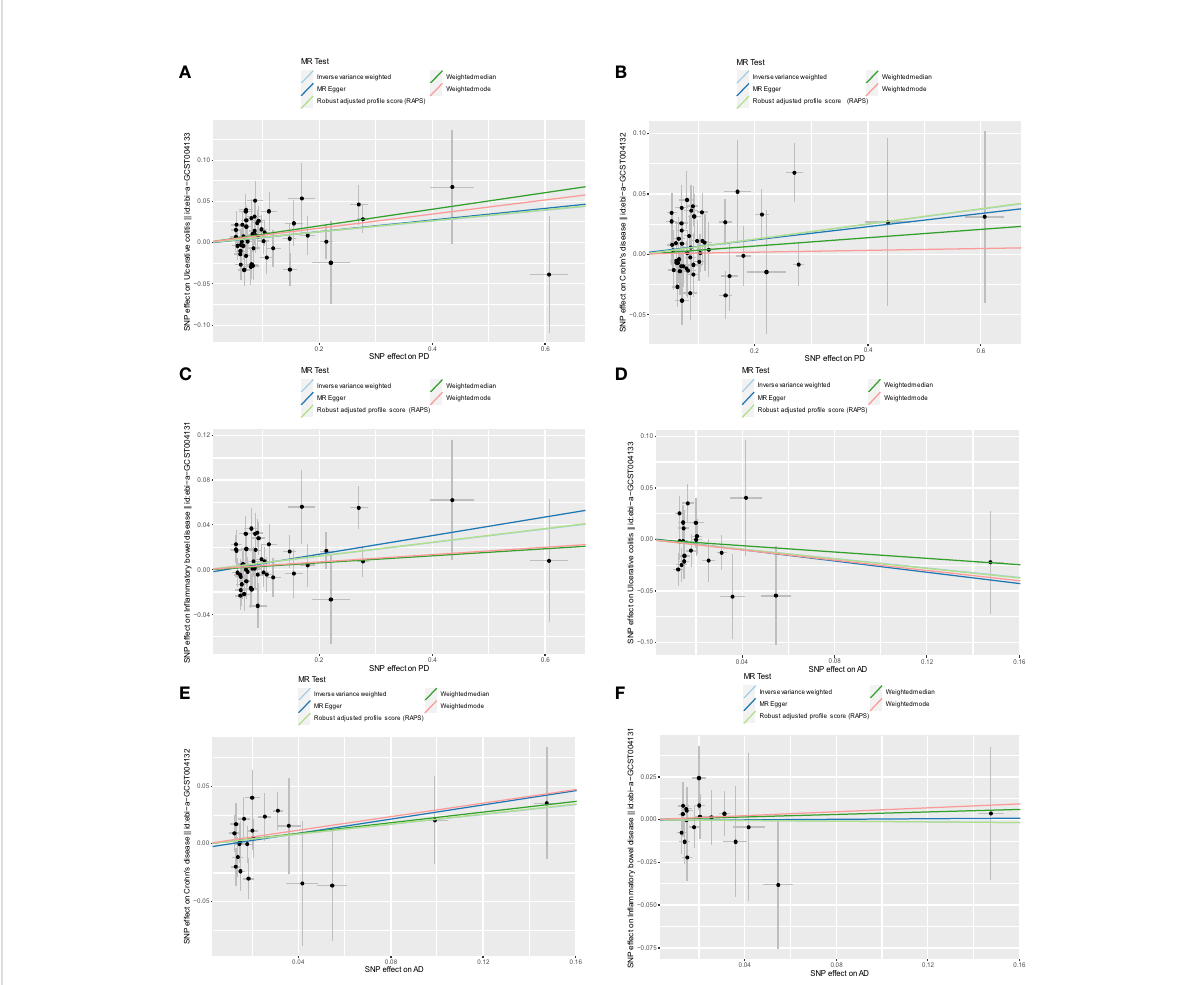
FIGURE 2 Scatter plots for MR analyses of the causal effect of PD and AD on IBD. (A) PD-UC. (B) PD-CD. (C) PD-IBD. (D) AD-UC. (E) AD-CD. (F) AD-IBD. Analyses were conducted using the conventional IVW, WM, MR-Egger, RAPS, and weighted mode methods. The slope of each line corresponds to the estimated MR effect per method. PD, Parkinson ’ s disease; AD, Alzheimer ’ s disease; IBD, in fl ammatory bowel disease; MR, Mendelian randomization; IVW, inverse variance weighted; UC, ulcerative colitis; CD, Crohn ’ s disease; RAPS, Robust Adjusted Pro fi le